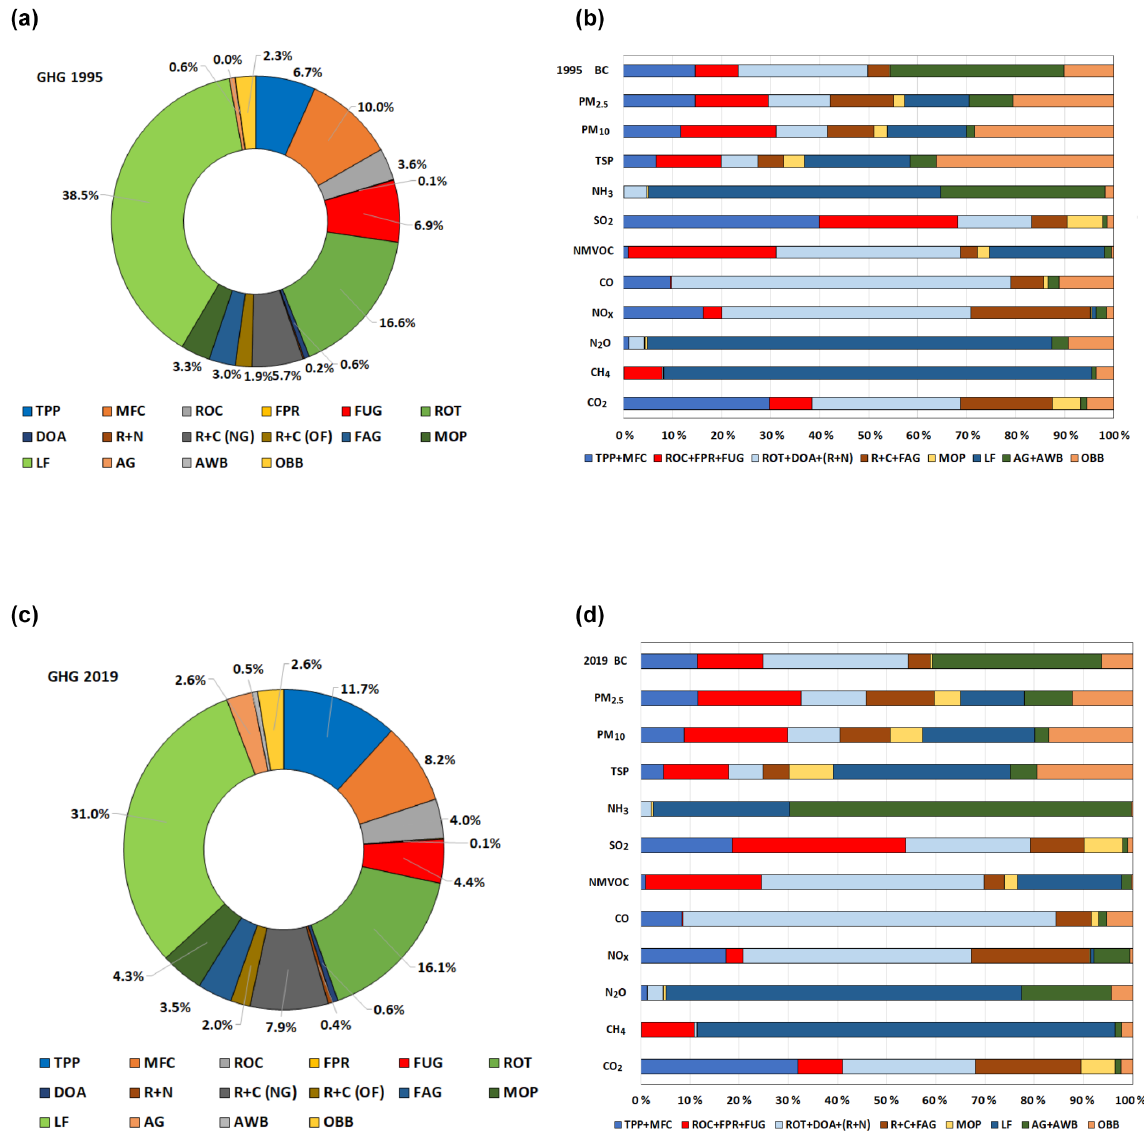
Figure 5. GHG participation by activity for Argentina for the years 1995 (a) and 2019 (c) (see Table 3) and sectoral SLCP pollutant contribution share of emissions for Argentina: (b) 1995 and (d) year 2019. Reference codes are provided in Table